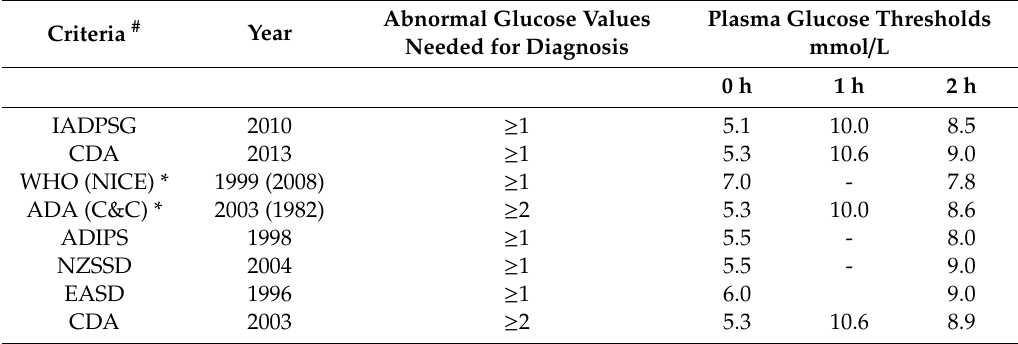
Table 1. Diagnostic criteria of major organizations for gestational diabetes mellitus (GDM) with diagnostic values for the 75 g oral glucose tolerance test over